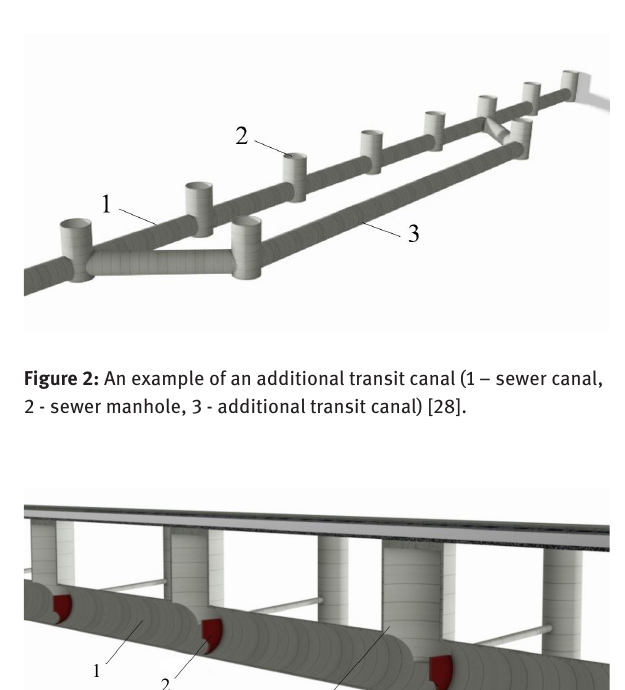
Figure 1: An example of a retention tank (1 - inlet canal, 2 - outlet canal, 3 - flow chamber, 4 – accumulation chamber) [28].